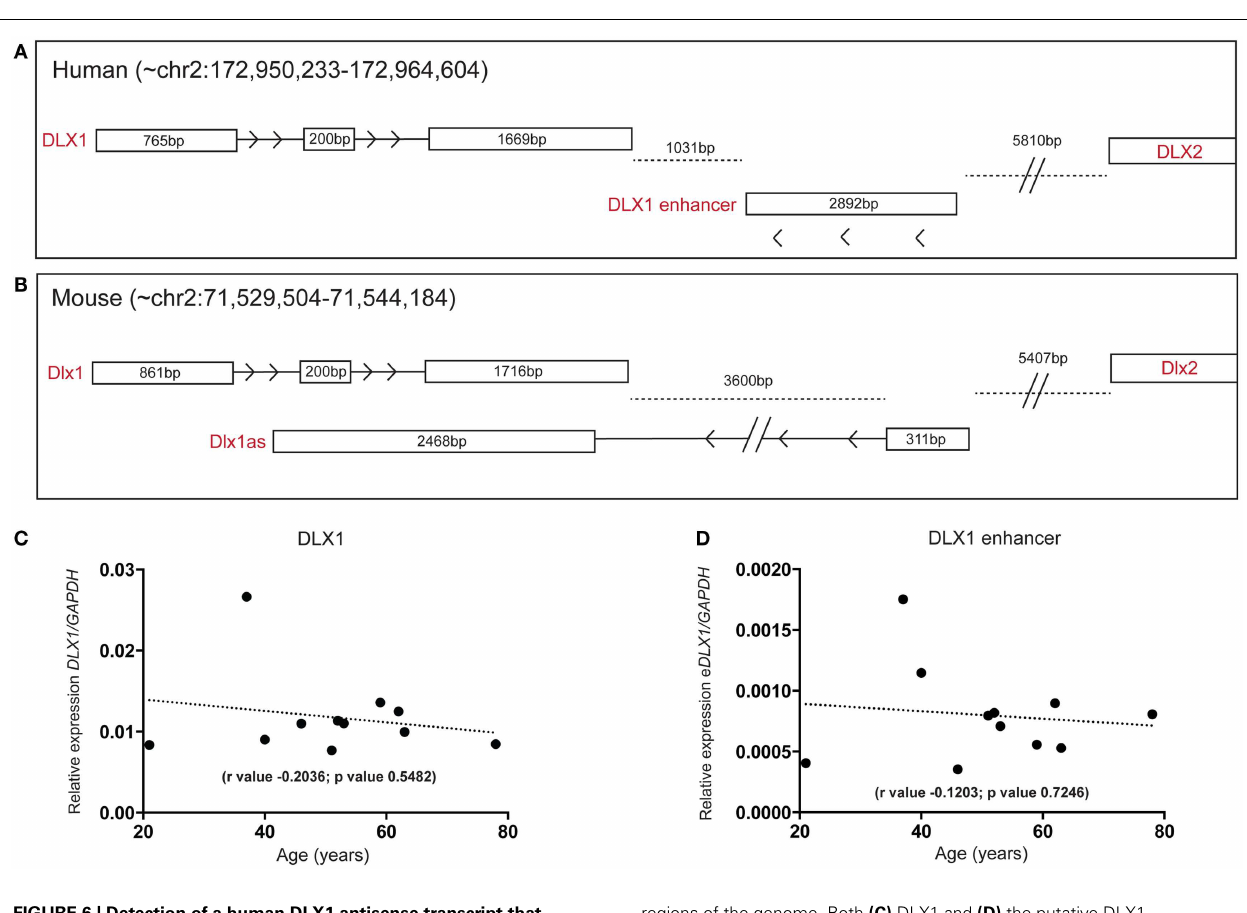
FIGURE 6 | Detection of a human DLX1 antisense transcript that may function as an enhancer in the human SEZ . Graphical depiction of the corresponding (A) human (DLX1, antisense transcripts, and DLX2) and (B) mouse (Dlx1, Dlx1as, and Dlx2)